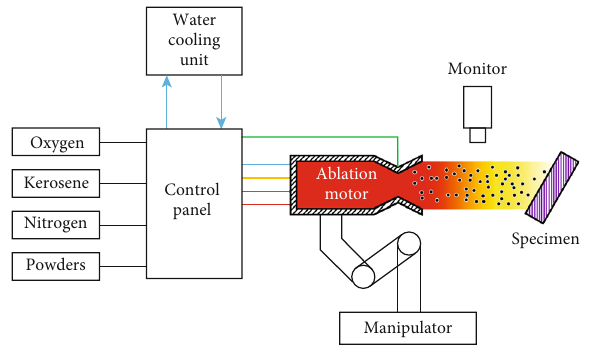
Figure 2: Schematic of the experiment